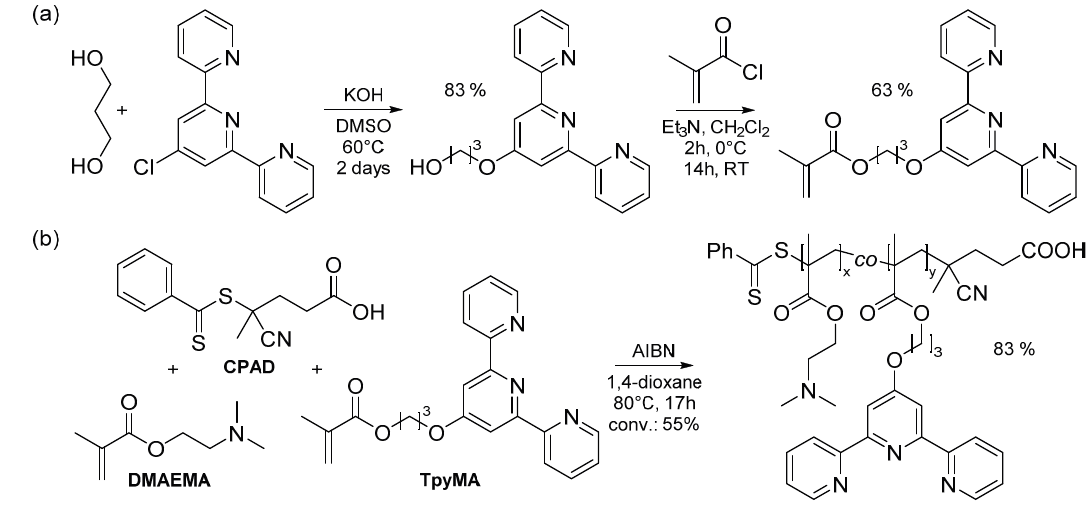
Figure 2. ( a ) Synthesis of terpyridine-functionalized methacrylate monomer; ( b ) Synthesis of side-chain terpyridine-functionalized poly(2-(dimethylamino)ethyl methacrylate).